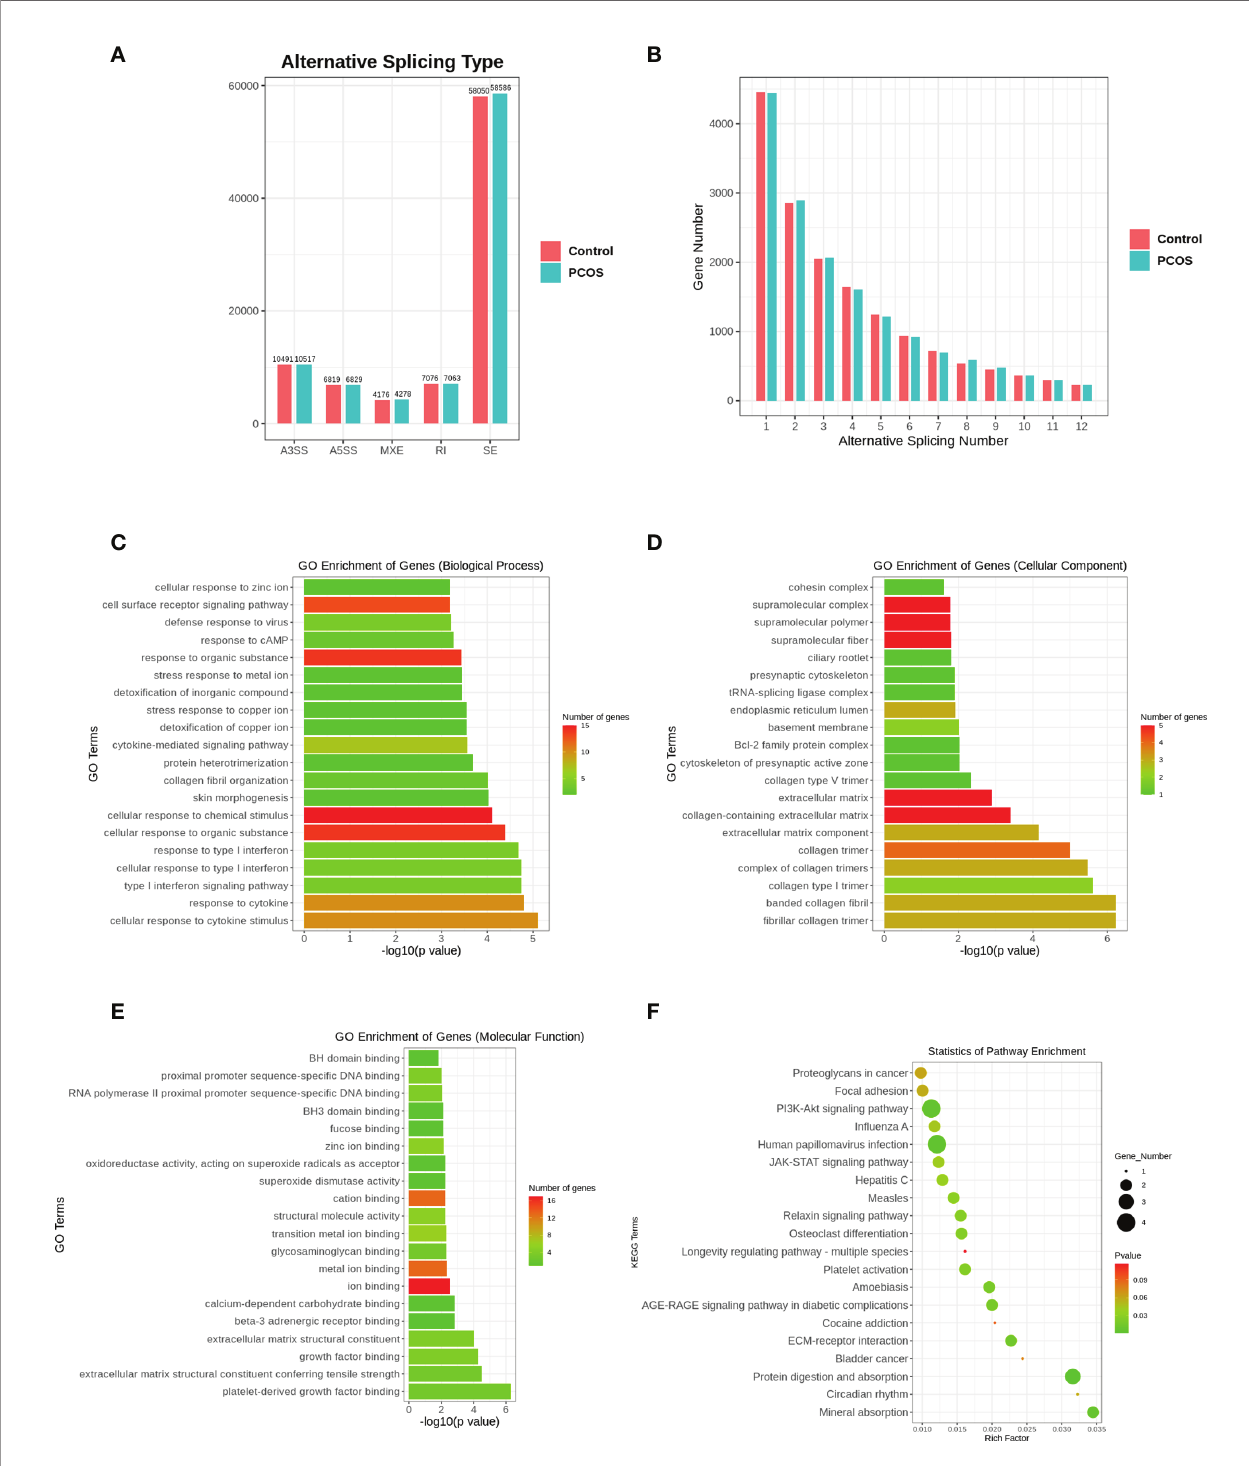
FIGURE 3 | Alternative splicing analysis. (A) Alternative splicing types. A3SS, alternative 3 ’ splice site; A5SS, alternative 5 ’ splice site; MXE, mutually exclusive exons; RI, Retained Intron; SE, skipped exon. (B) Alternative splicing number. (C) GO enrichment analysis of alternative spliced genes in cellular component. (D) GO enrichment analysis of alternative spliced genes in molecular function. (E) GO enrichment analysis of alternative spliced genes in molecular function. (F) KEGG enrichment analysis of alternative spliced